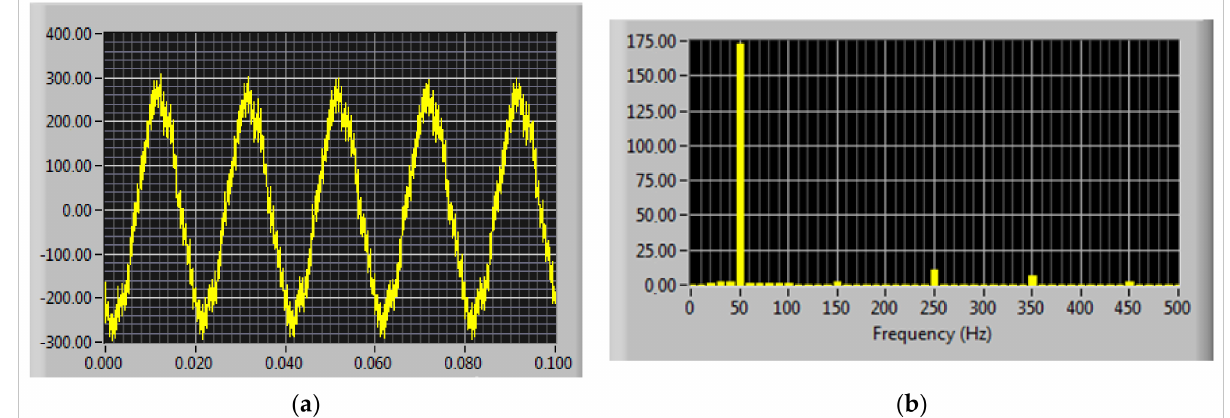
Figure 13. Current flowing through the A-phase of transformer at 16:11 on a working day: ( a ) waveforms; ( b ) harmonic